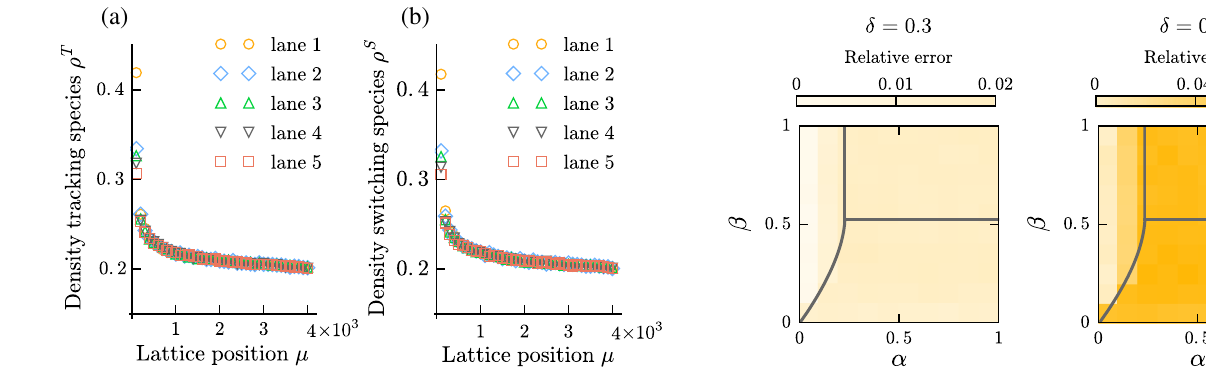
FIG. 17. Relative deviation of the density species fraction from δ for the special case of W ¼ 2 lanes and L ¼ 4096 sites. Color denotes simulation results for the relative deviation and thus the error that is made when assuming a density species fraction of value δ . Lines indicate the phase boundaries as predicted by our